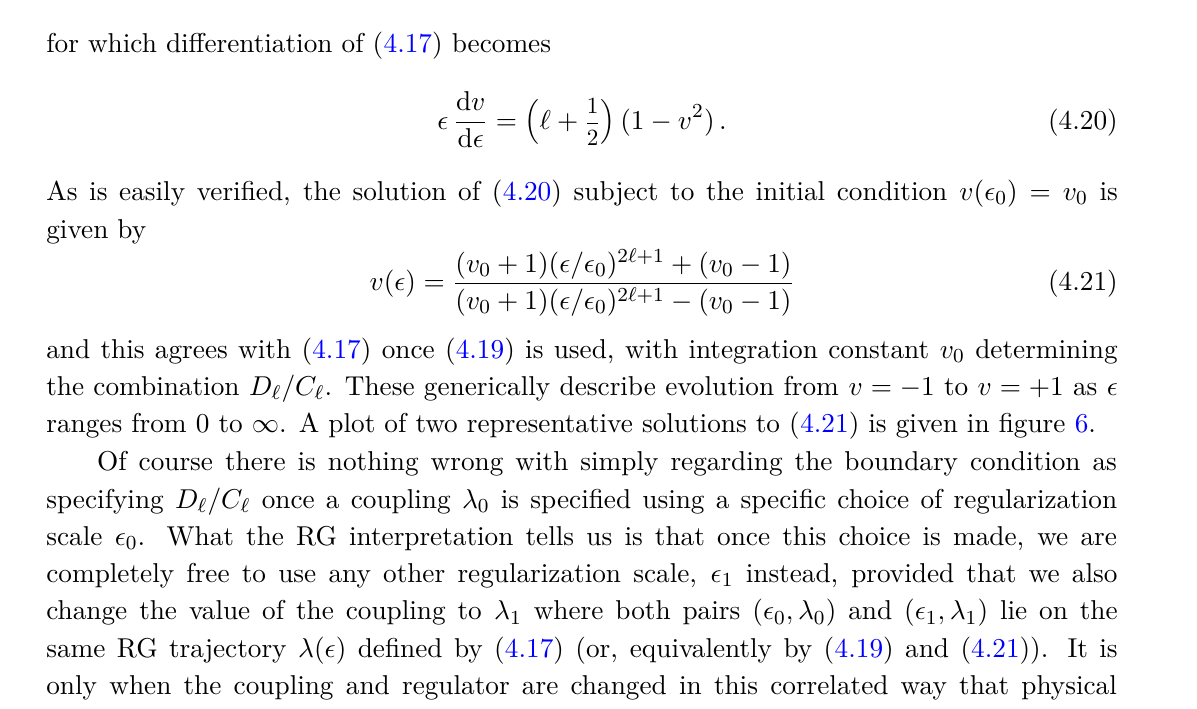
Figure 6 : The two categories of RG flow described by the evolution equation (4.20). This figure plots the universal variable v ( (cid:15) ) against ln( (cid:15)/(cid:15) | v | > 1 and v < 1 , and the plot shows the sign of | v | − 1 is invariant because v = ± 1 are fixed points. (figure taken from